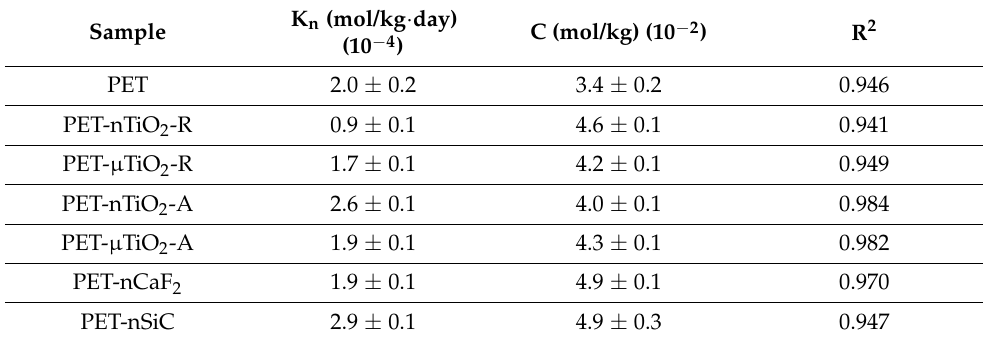
Table 3. Coefficients of yarn degradation kinetics.